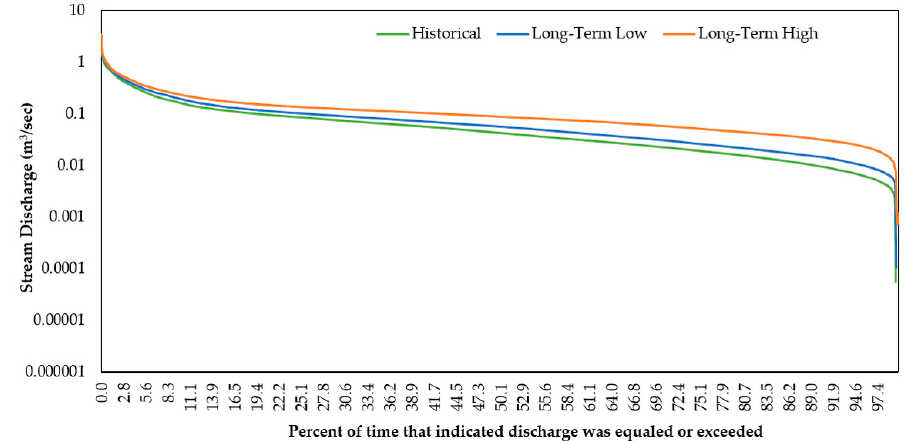
Figure 10. Cork Brook flow duration curves simulated for high and low CO 2 emission scenarios by the